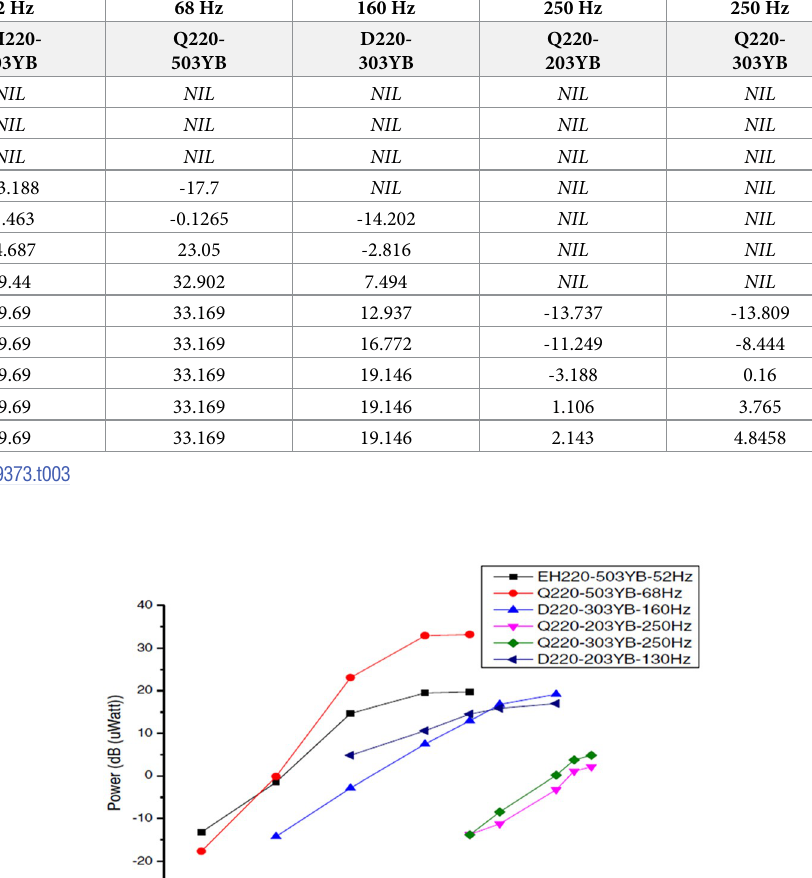
Table 3. The value of power versus sound level for variety type’s piezoelectric transducer used through the experiment [22]. Sound Level (dB)